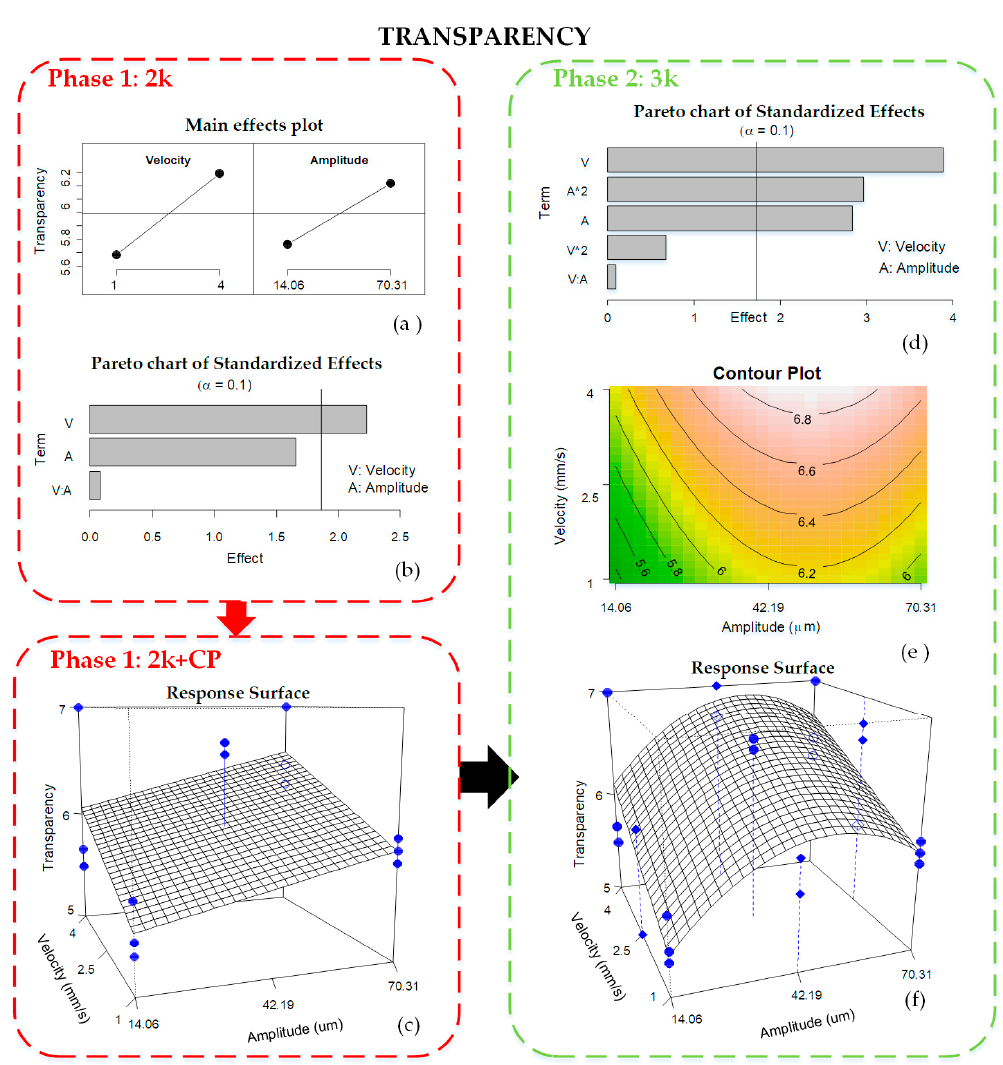
Figure 4. Analysis of transparency results: ( a ) main effects plot 2 k ; ( b ) Pareto chart of effects 2 k ; ( c ) response surface 2 k + CP; ( d ) response surface 3 k ; ( e ) Pareto chart of standardized effects 3 k ; and ( f ) contour plot of final 3 k model; k = 2.